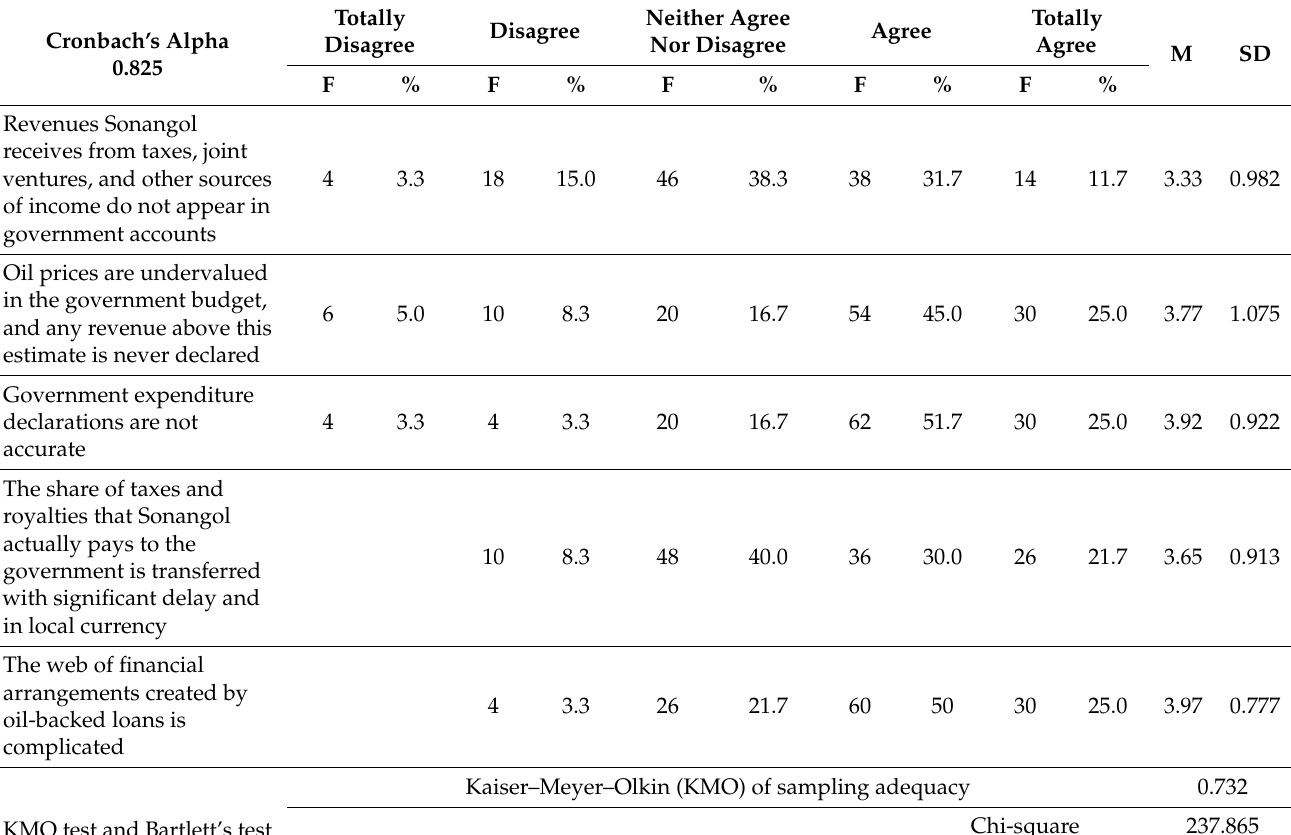
Table 12. Reasons for the lack of competitiveness of Angola’s oil sector.